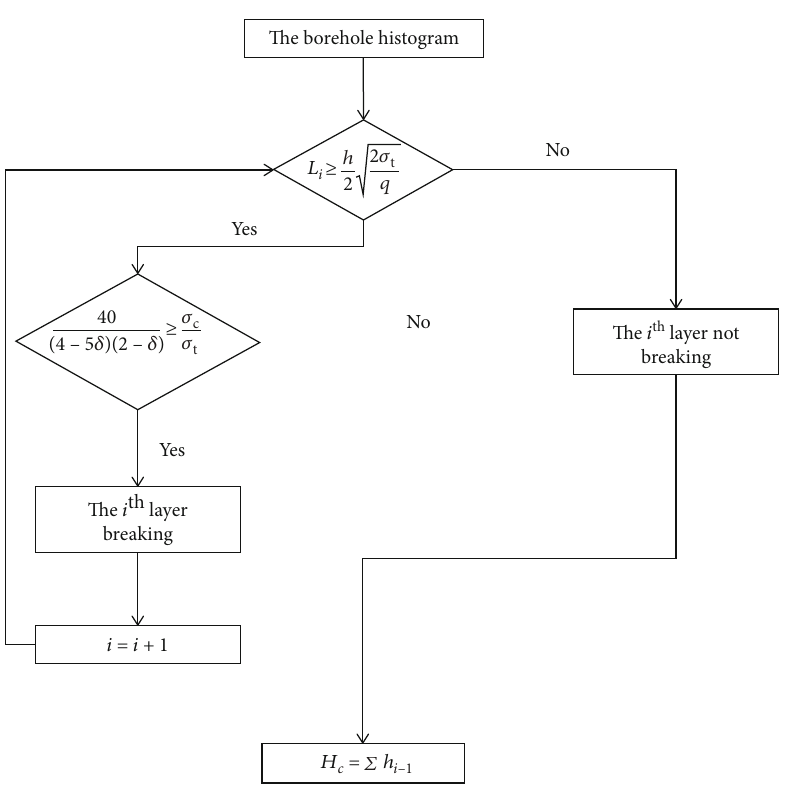
Figure 7: Discrimination process of height of water- fl owing fracture zone in the